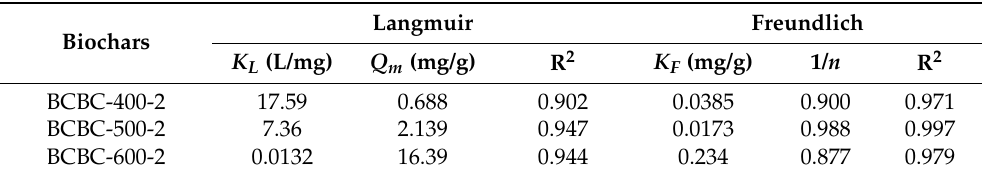
Table 3. Regression parameters of isotherms for adsorption of nitrate by BCBC-400-2, BCBC-500-2, and BCBC-600-2.